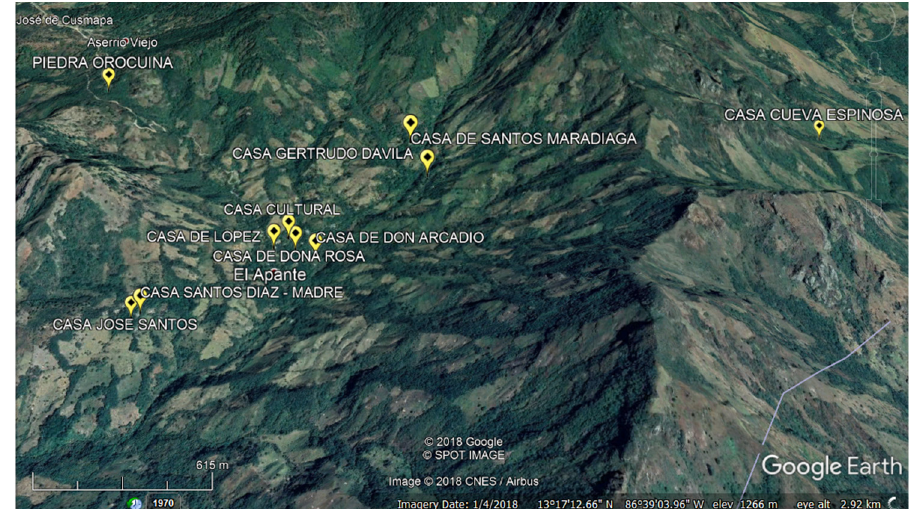
Figure 3. Research localities indicated by yellow icon (and described in capital letters) in the relief map of El Apante community. Source: Google Earth and GPS mapping.